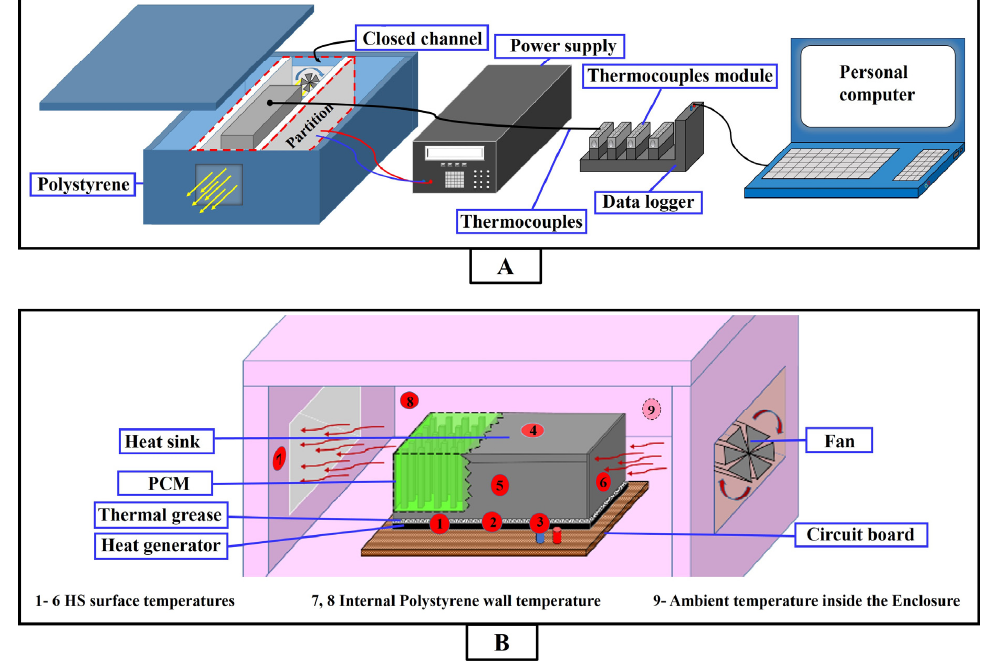
Figure 1. Schematic diagram of the whole thermal management experimental setup ( A ); and zoomed in section of heat sink (HS) enclosure ( B ).